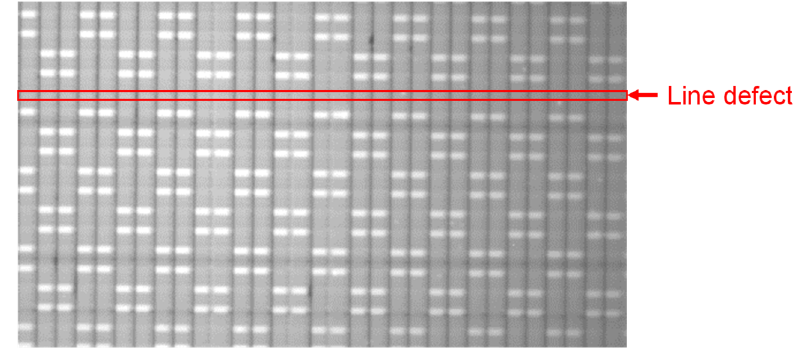
Figure 19. Captured image of flat panel display with a line defect by Chip A.